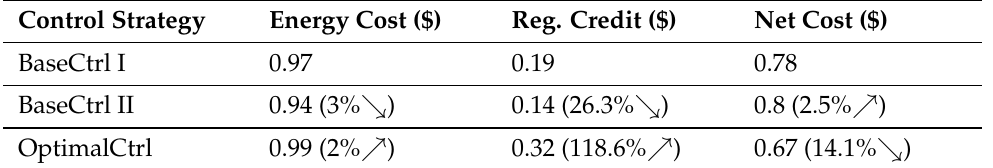
Table 1. Cost comparisons for different control scenarios.